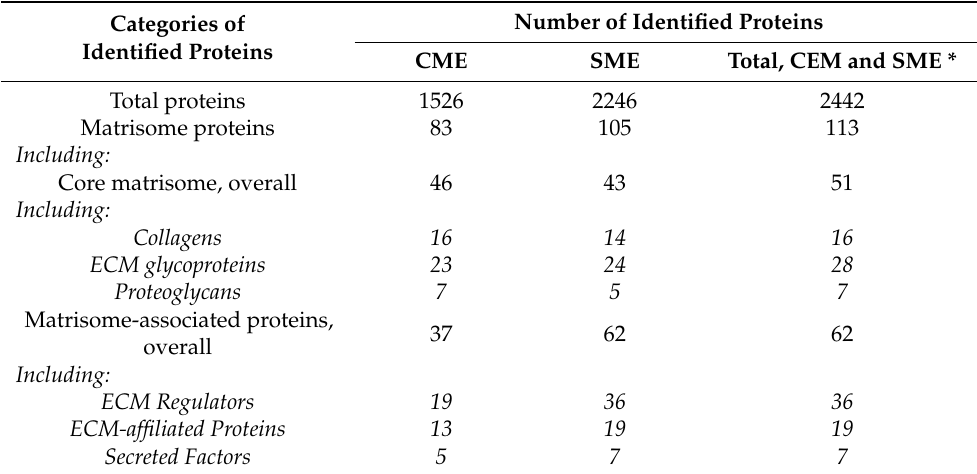
Table A8. Composition of mouse kidney matrisome proteins identified in this study depending on the ECM enrichment method.